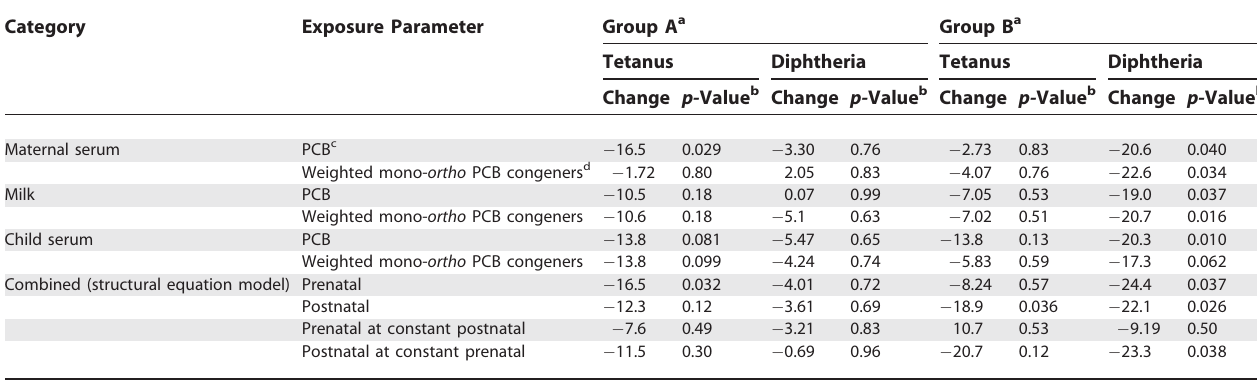
Table 3. Change in Serum Antibody Concentrations after Childhood Vaccinations against Diphtheria and Tetanus Associated with a Doubling in Prenatal or Postnatal Exposure to PCBs Category Exposure Parameter Group A